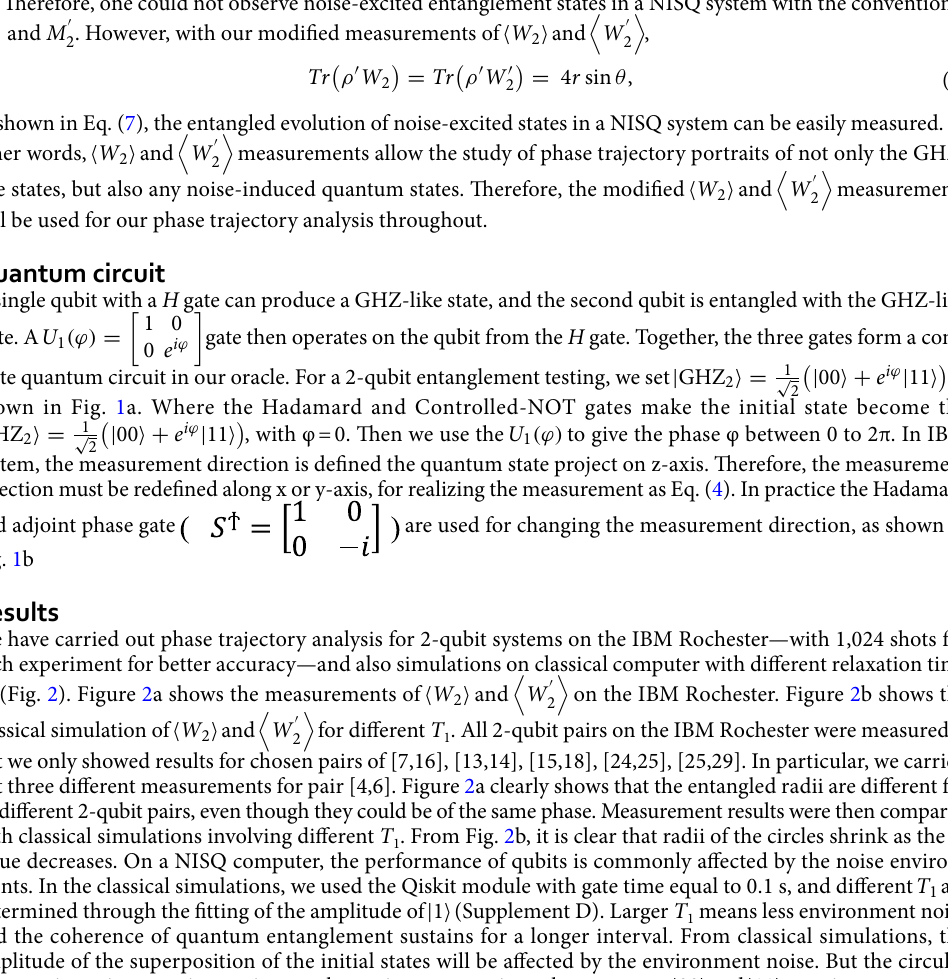
Figure 1. ( a ) The quantum circuit for preparing a 2-qubit GHZ-like initial state, with φ between 0 and 2π. H represents the Hadamard gate, U 1 (ϕ) is a gate that rotates a quantum state about the z axis to impart phase φ, and CNOT gate entangles the two qubits. ( b ) The quantum circuit of YX measurement for the 2-qubit pair. In our measurement method, the and H need to be prepared before the